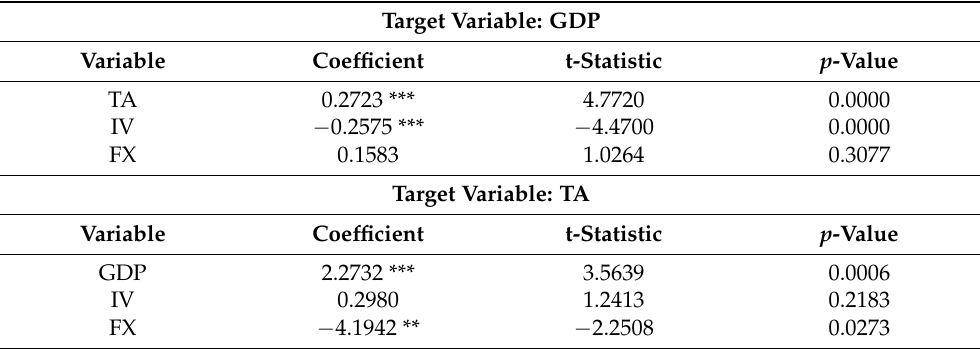
Table 5. Long-Run Levels Symmetric Test